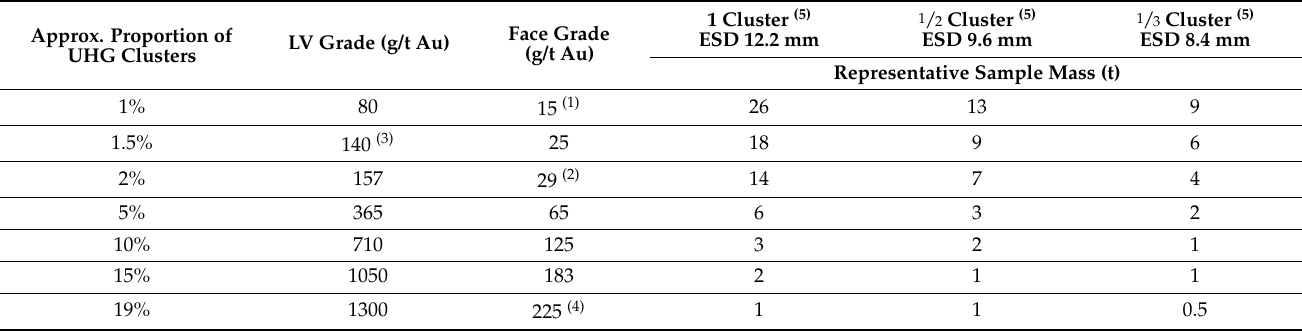
Table 17. Face RSM values for ultra-high grade cluster containing LV (0.7 m width) scenarios based on diluted face grade at 3.5 m width. RSM reported at a precision of ± 20% at the 68% confidence limits and rounded to the nearest tonne. LV: laminated vein; ESD: equivalent spherical